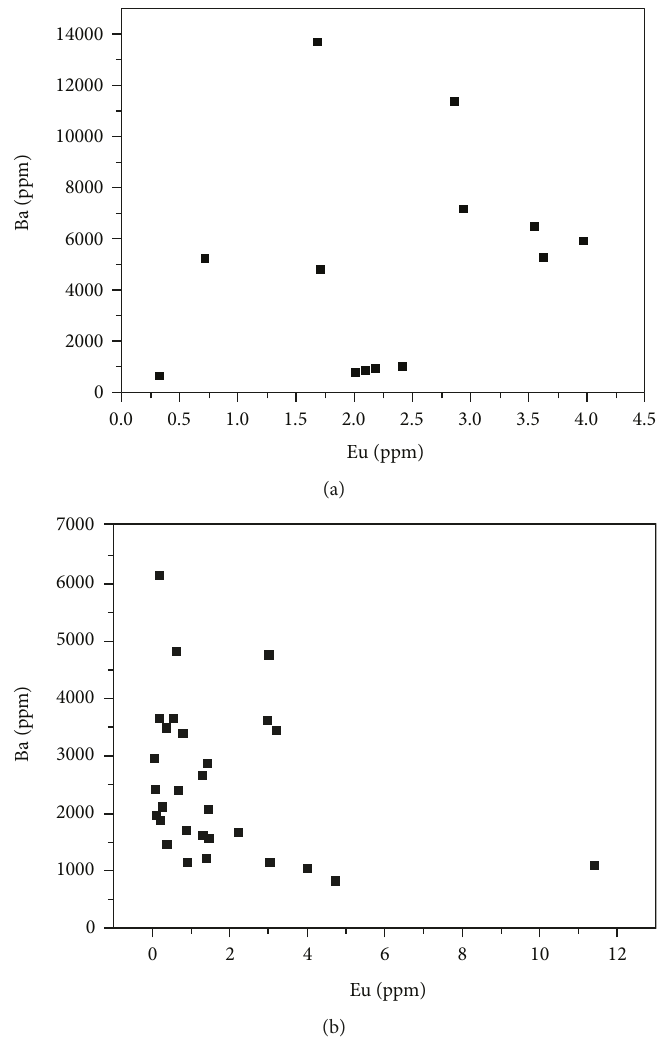
Figure 6: The Ba and Eu data reported in previous studies using the same instrument. (a) Ba and Eu from shale in the Niutitang Formation, South China [15]. The Ba/Eu ratio was varied from 391.54 to 8146.43. (b) Ba and Eu from phosphate nodules in the Mufushan Formation [20]. The Ba/Eu ratio ranges from 95.53 to